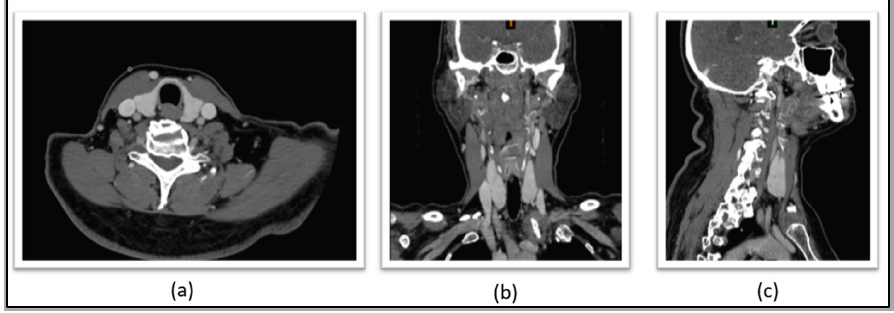
Figure 2. Thyroid seen in differentiated grayscale, which is shown in: ( a ) axial, ( b ) sagittal and ( c ) coronal.